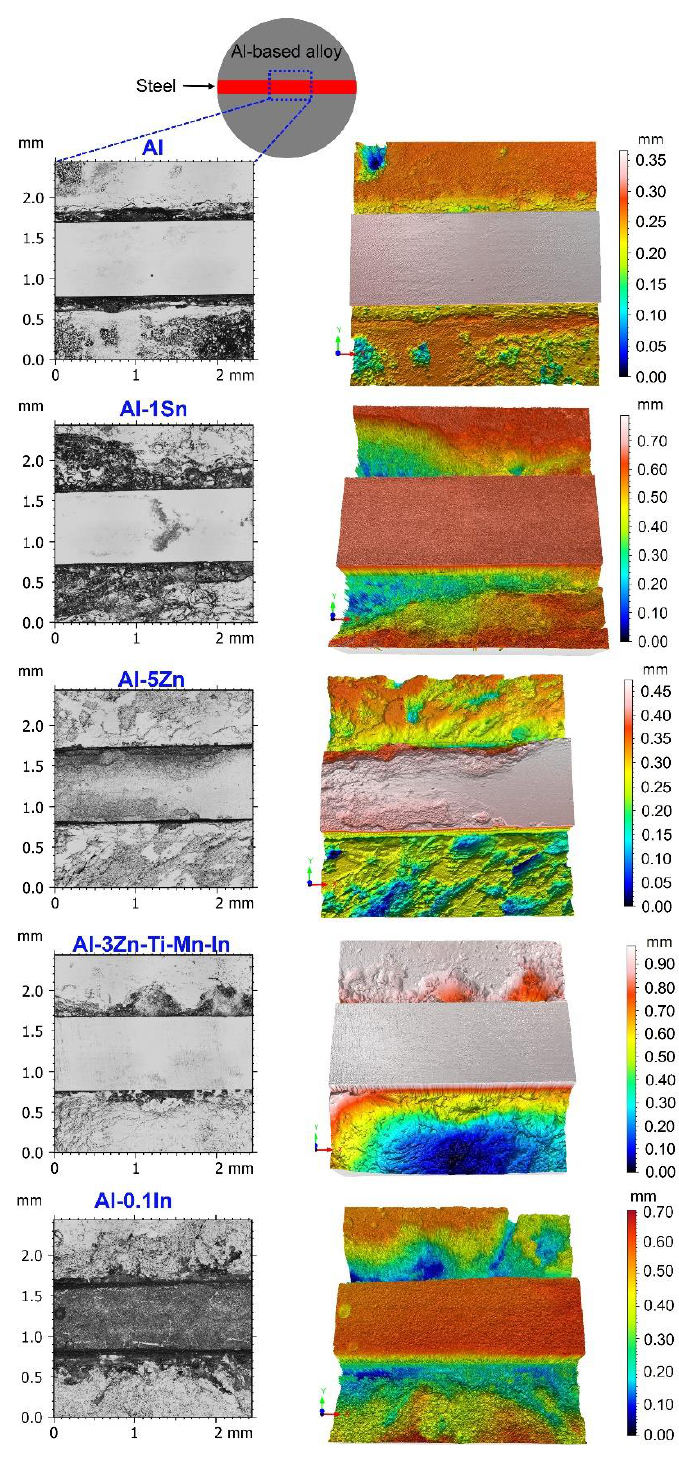
Figure 15. Selected confocal laser scanning images on selected area of the galvanic couple assembly and corresponding 3D images after corrosion product removal.